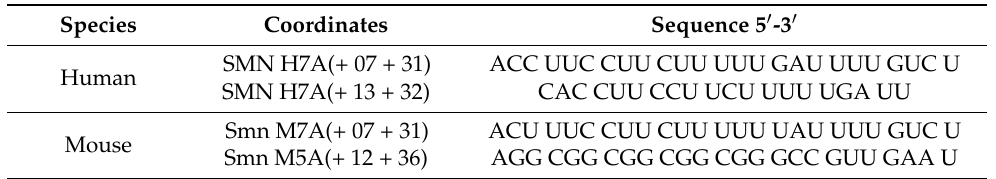
Table 4. Sequences and binding co-ordinates of recommended positive control exon skipping AOs designed for the human SMN and mouse Smn